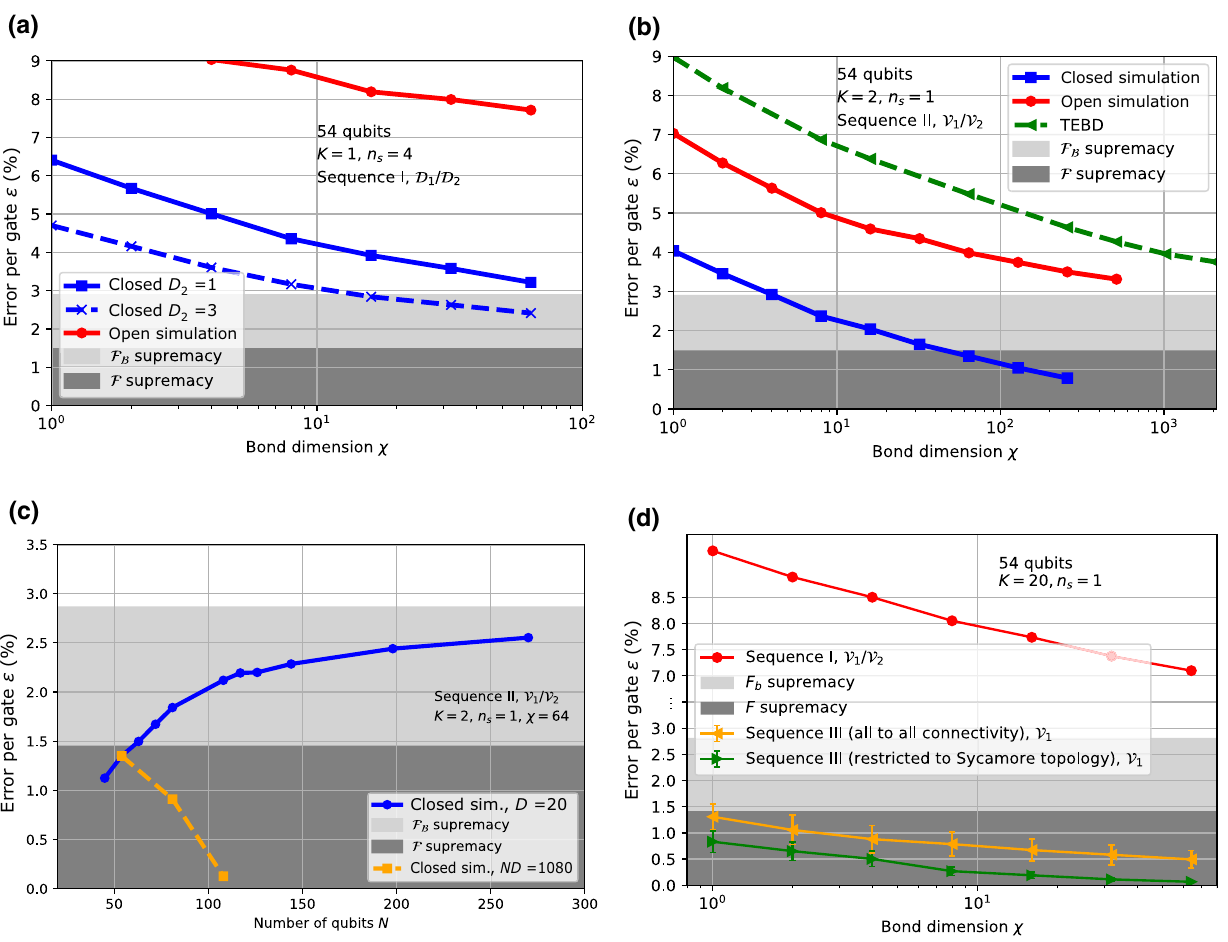
FIG. 2. Error rates achieved in our simulation. (a) Error rate per gate (cid:5) as a function of bond dimension χ for the supremacy sequence I. In the gray regions the quality of the output is as good or better than that produced in Ref. [3]; see the text. Light √ F . Dark gray denotes (cid:5) ≤ 1.4%; the gray denotes (cid:5) ≤ 2.8%; the simulation fidelity matches the experiment assuming that F B = simulation fidelity matches the experiment even assuming that F B = F . We denote by D 2 the number of layers treated exactly at the end of the calculation; see Sec. IV C. The labels D 1 , D 2 , V 1 , V 2 indicate the grouping used in the construction of the matrix product state (MPS); see the discussion around Fig. 7. We denote by n s the number of sweeps used in the DMRG optimization; K is the number of circuit layers. (b) Same as (a) for sequence II. (c) Error rate per gate (cid:5) as a function of the number of qubits N for sequence II. Here n c is increased at fixed n b = 5 and χ = 64. Blue curve denotes the fixed depth D = 20. Orange curve denotes the fixed number of two-qubit gates, i.e., ND = 1080. (d) Comparison between the error rates of sequences I and III in open simulations. Each point in the sequence III curves is averaged over ten graphs, with error bars corresponding to one standard deviation. Orange curve denotes the QAOA circuit assuming perfect topology. Green curve denotes the QAOA circuit using only the nearest-neighbor connectivity of the Sycamore